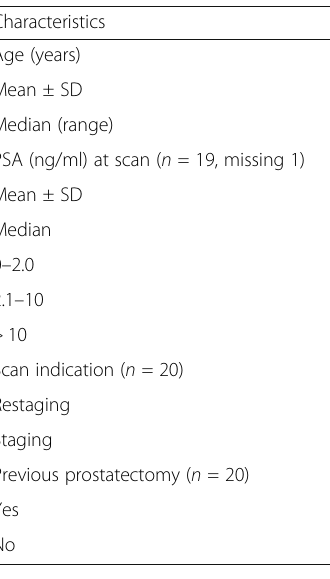
Table 2 Patients